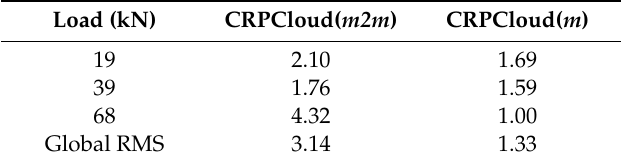
Table 17. RMS (mm) in the CRP-DPA comparison beam#2 EOS M3.